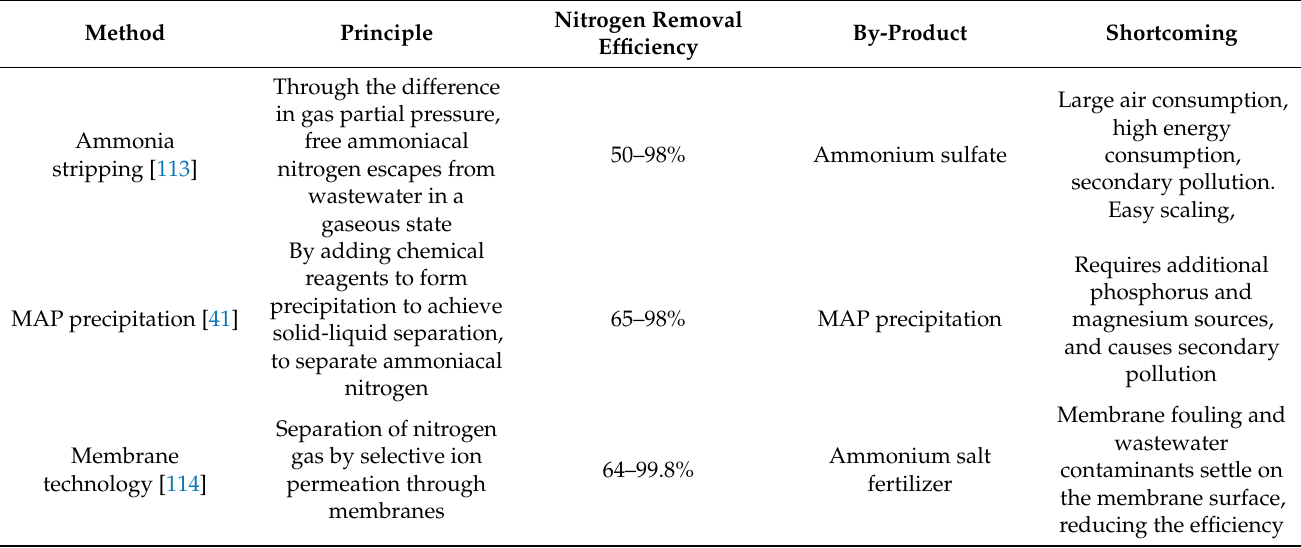
Table 3. Indicators of nitrogen recovery processes.